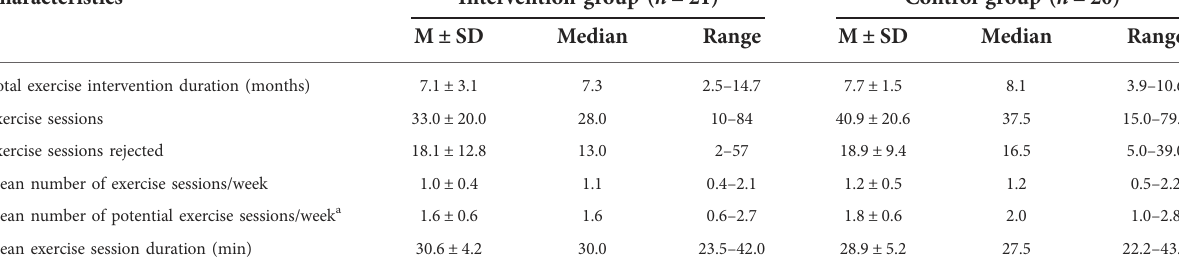
TABLE 4 Exercise characteristics by group.